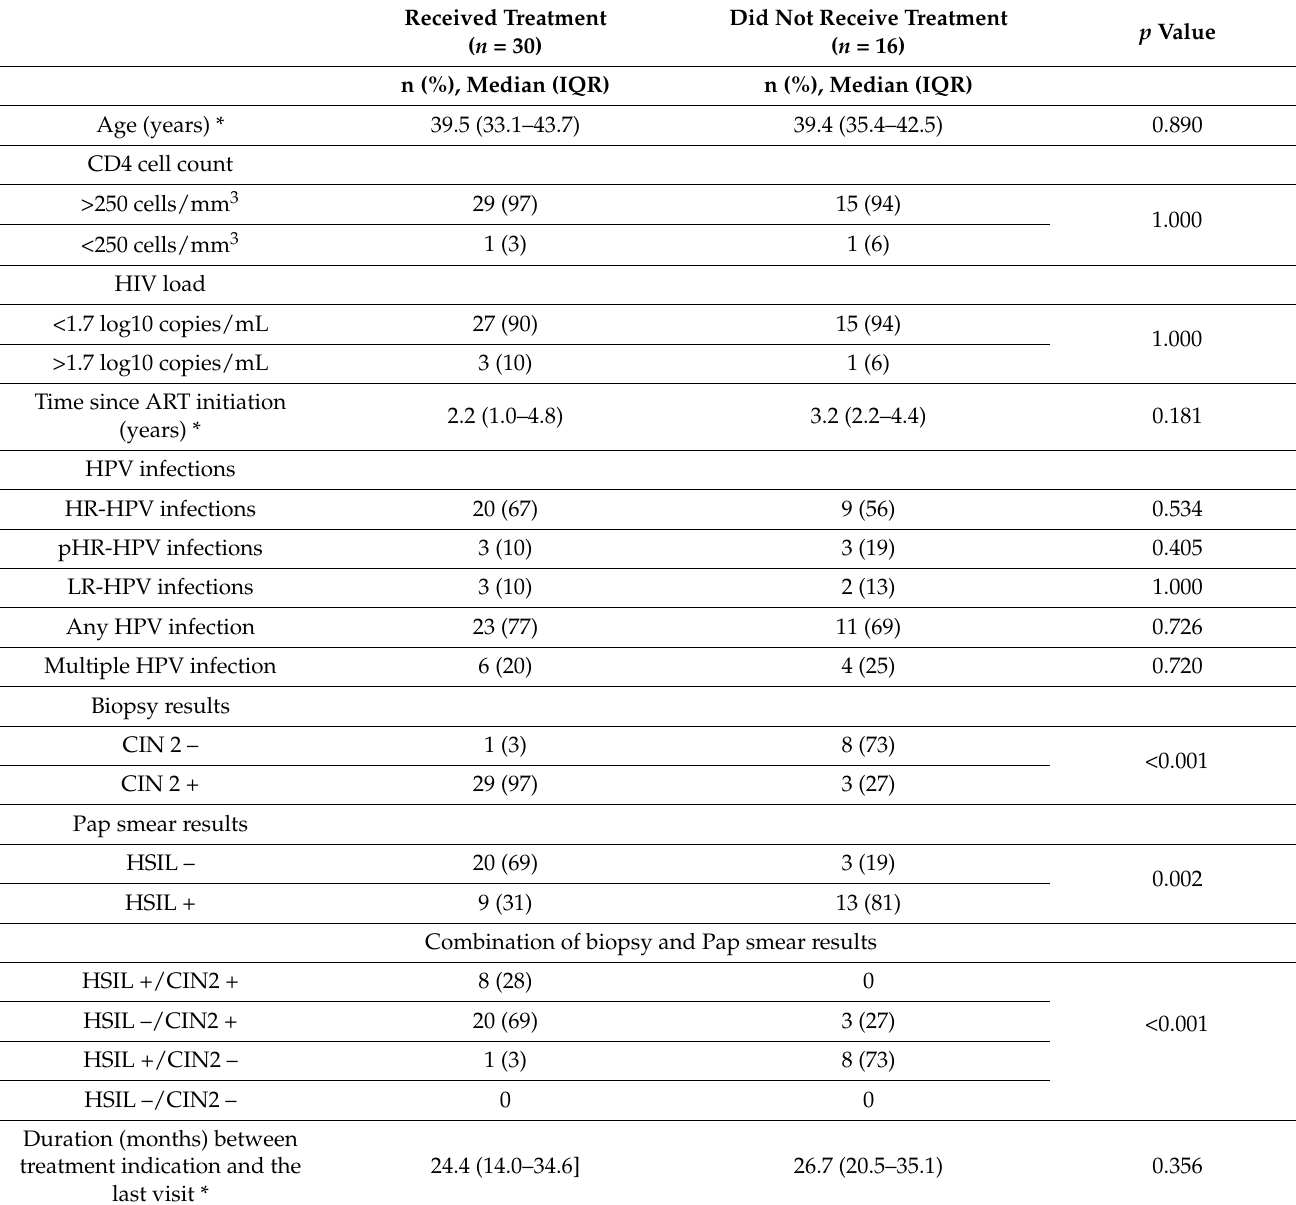
Table 1. Baseline characteristics at the time of indication among women who received treatment and women who did